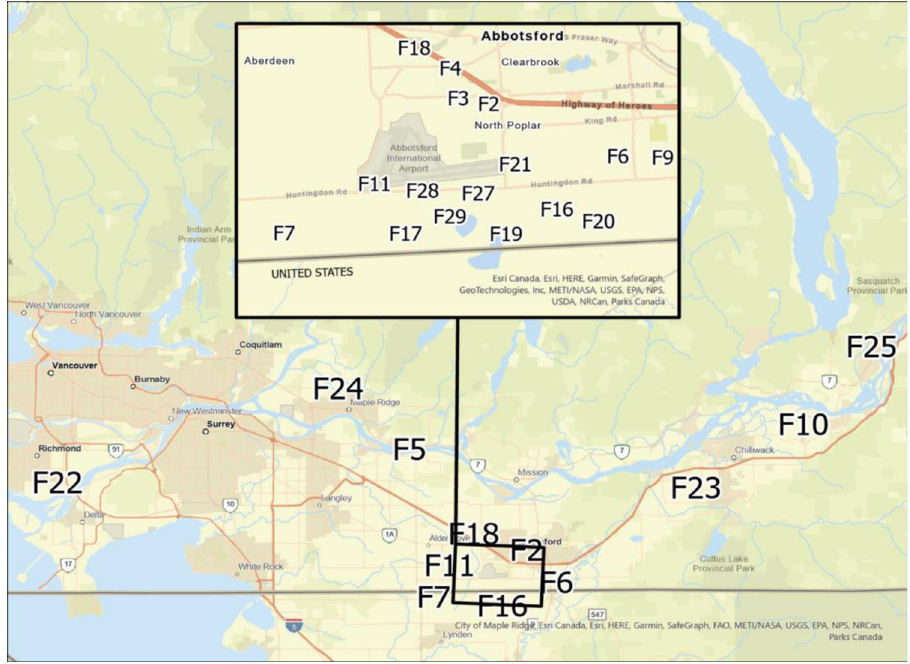
Fig 1. Overview of the field sites monitored during this study. Reprinted from ArcGIS Online maps under a CC BY license, with permission from ESRI, original Copyright 2018 ESRI. The copyrights belong to ESRI, but according to the terms of use, the copyright holder does not need to apply for permission to use because it is free for academic publications, and can be used freely and commercially under the CC BY 4.0 license.